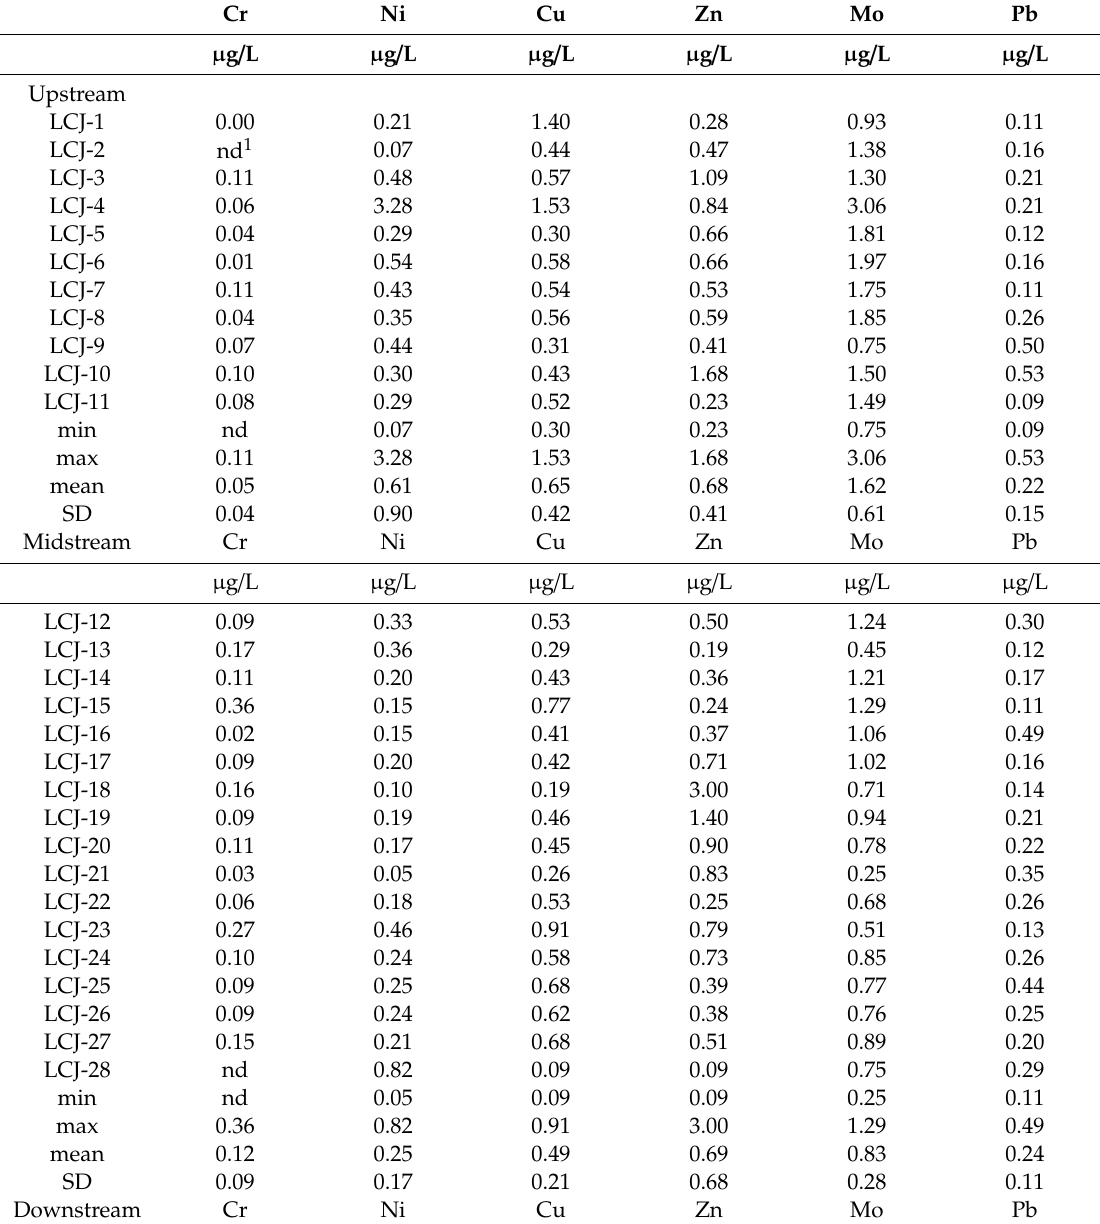
Table 2. Concentrations and statistics of dissolved heavy metals in the Lancangjiang River and world’s major